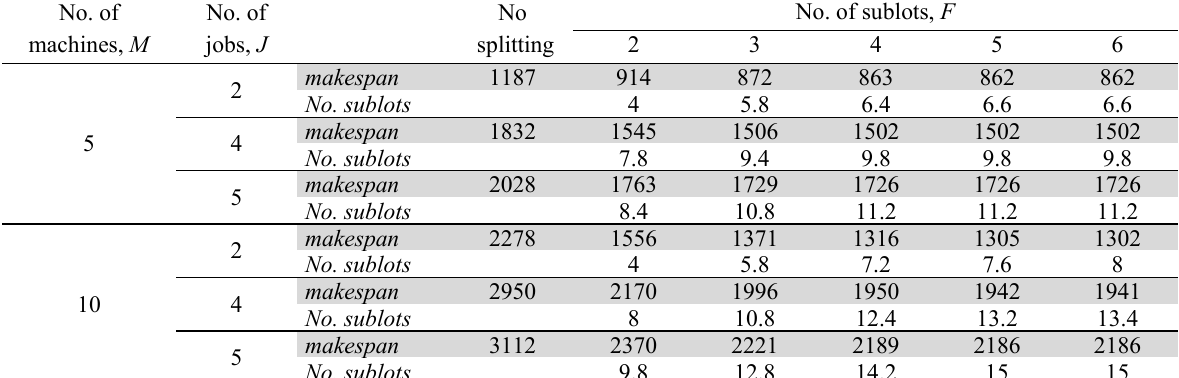
Average results under the different splitting conditions No. of machines, M